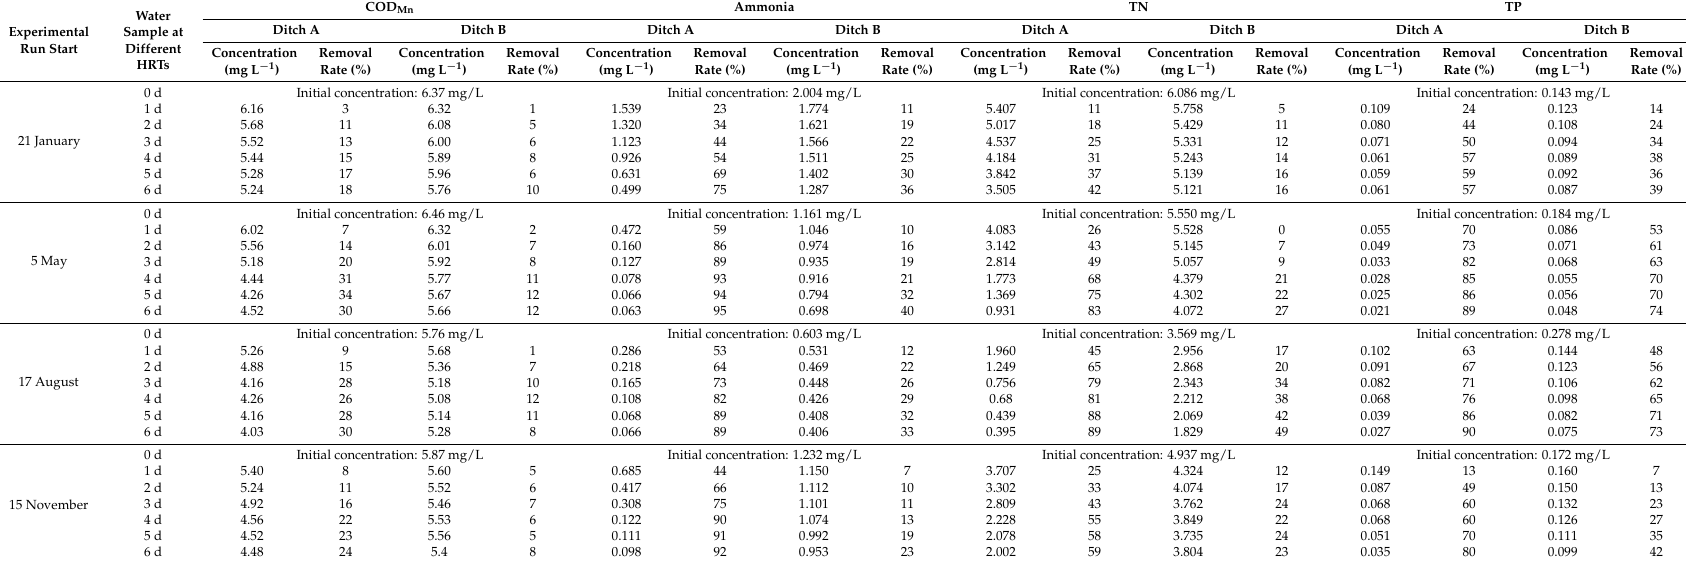
Table 2. Purification effects of the ecological slope revetment in different experimental